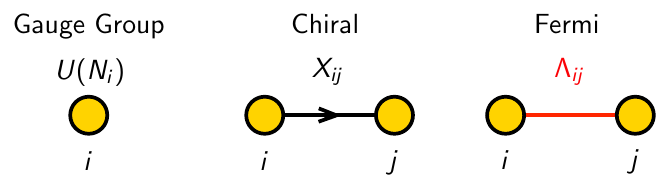
Figure 4 . Basic building blocks of 2 d (0 , 2) quiver